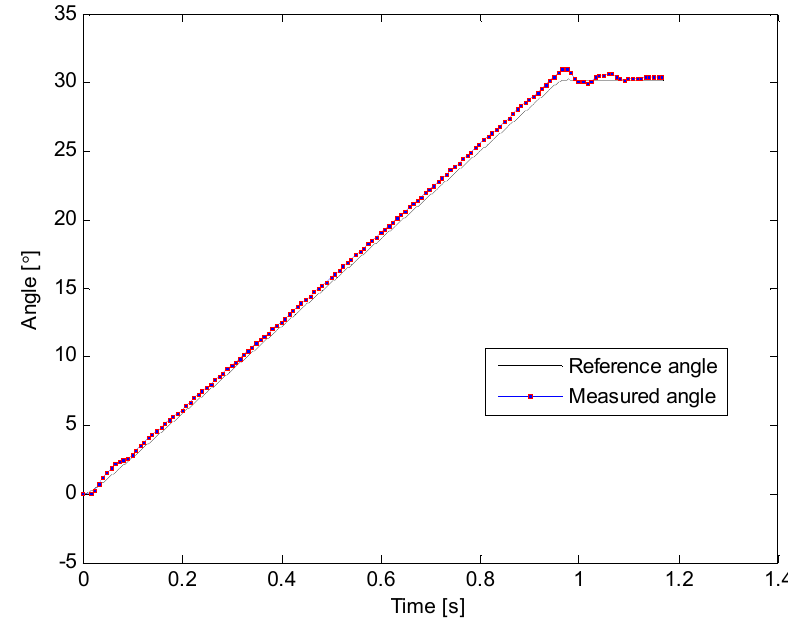
Figure 11. Inclination angle vs. time—first trial.